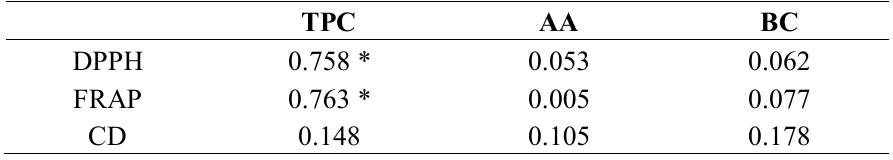
Table 5. Correlation (correlation coefficient, r 2 data) between the antioxidant compounds and the antioxidant activity of selected fruits.